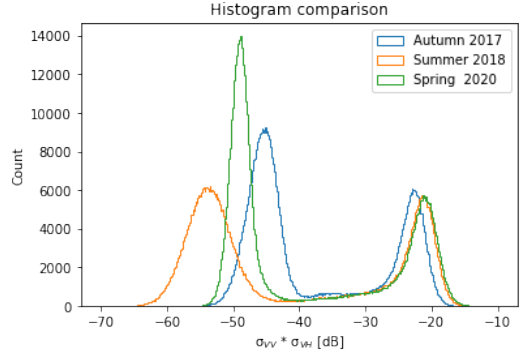
Figure 5. Comparison of histograms for three scenes. Each scene represent a 3 month period and is the pixel-wise average of 7 scenes.